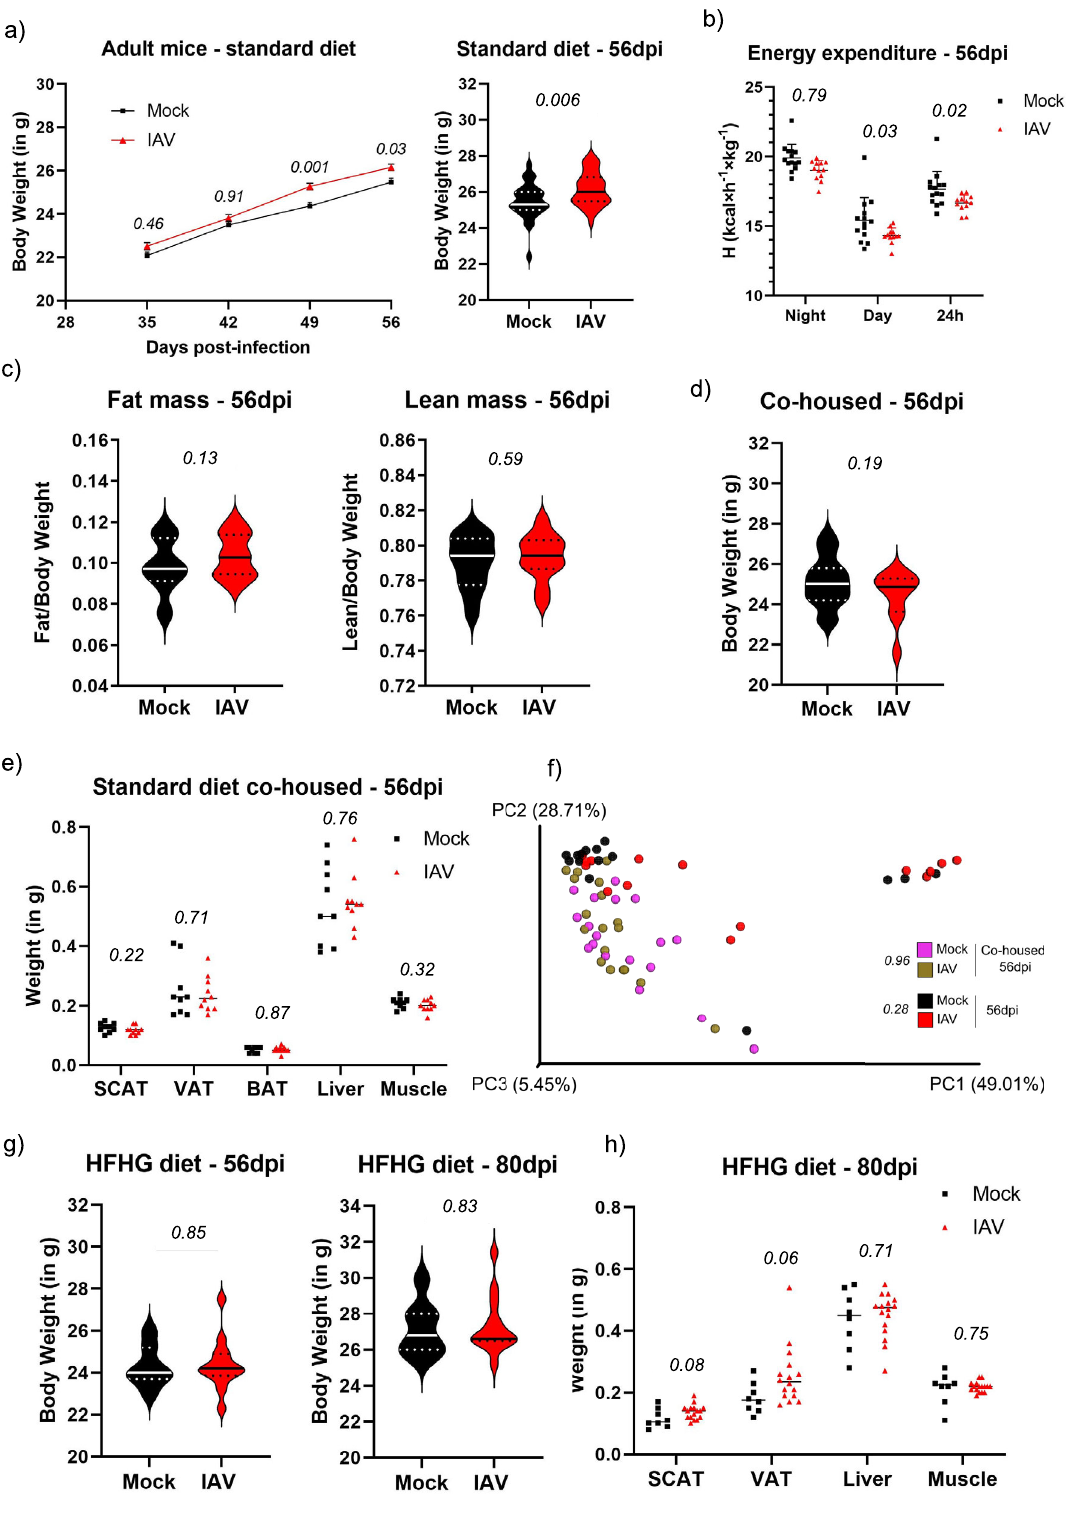
(Fig. 2h) with about 30% median effect size in VAT. This suggests that early life infections could sensitize to adulthood food-induced gain of fat mass in speci fi c depots. The mechanistic link between the altered microbiota after early life IAV infection and the metabolic changes will require additional